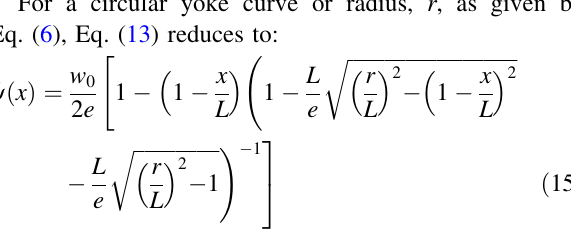
ffiffiffiffiffiffiffiffiffiffiffiffiffiffiffiffiffiffiffiffiffiffiffiffiffiffiffiffiffiffiffiffiffi r